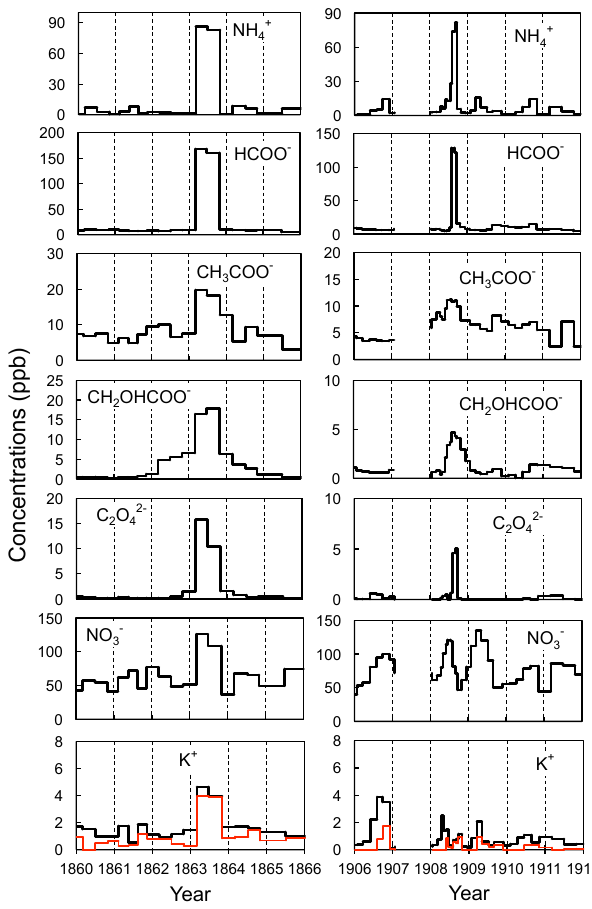
Figure 3. Chemical fingerprint of two ammonium events dated in the GRIP 93 firn core at 1863 AD (left) and 1908 AD (right). NH + is ammonium, HCOO − is formate, CH 3 COO − is acetate, 4 CH 2 OHCOO − is glycolate, C 2 O 2 − is oxalate, NO − is nitrate, and 4 3 K + is soluble potassium. For soluble potassium, the black and red curves refer to total and fine fraction, respectively (Sect.